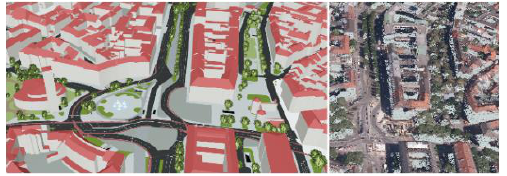
Figure 4: Interactive visualization of different data within a common 3DCityDB Web-Map Client and corresponding coloured point cloud